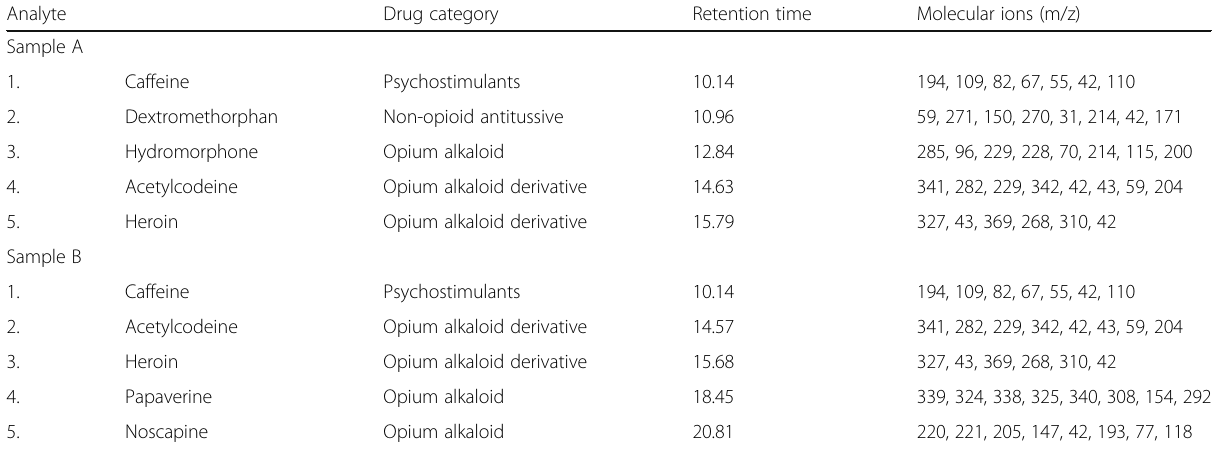
Table 2 Results of qualitative analysis of “ morphia tablets ” Analyte